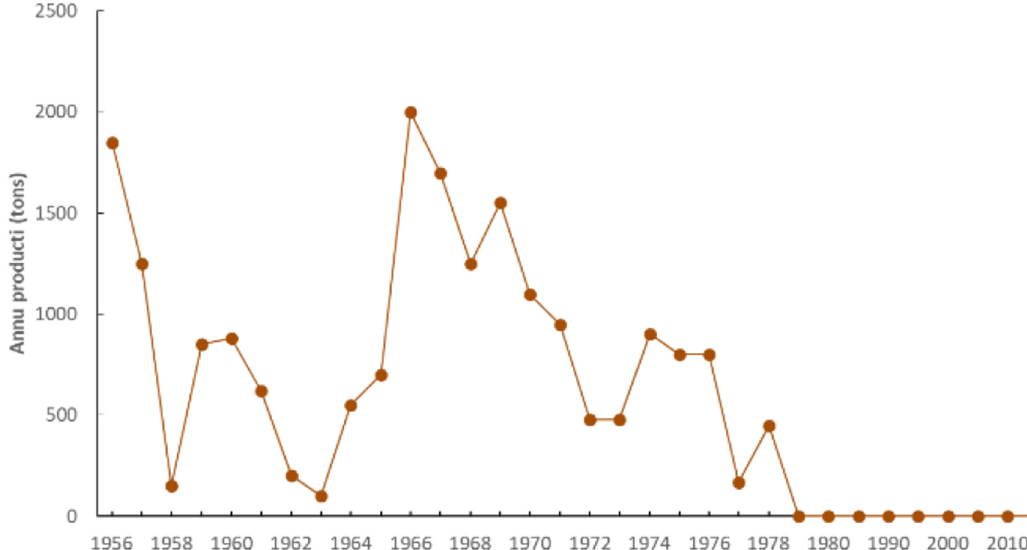
Fig. 2. Annual production of the large yellow croaker from 1956 to 2015 in Guanjingyang, China.